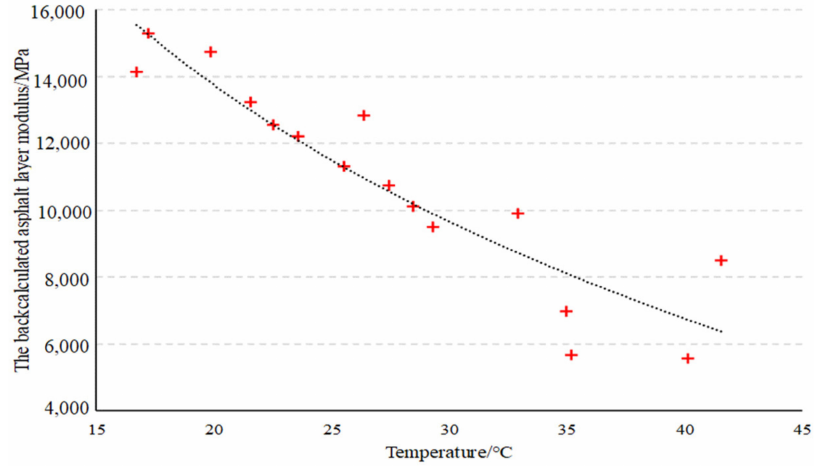
Figure 3. Modulus–temperature model (at middle